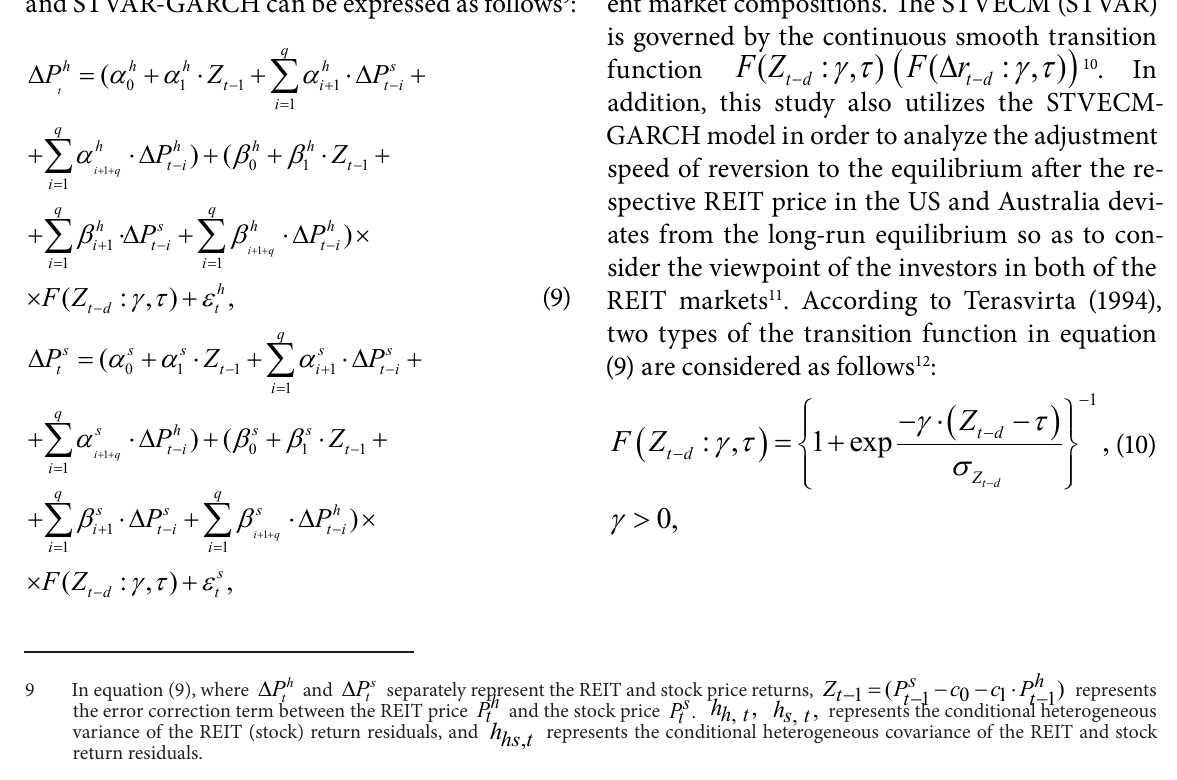
the error correction term between the REIT price h t P and the stock price . s t P represents the conditional heterogeneous variance of the REIT (stock) return residuals, and , hs t h represents the conditional heterogeneous covariance of the REIT and stock return